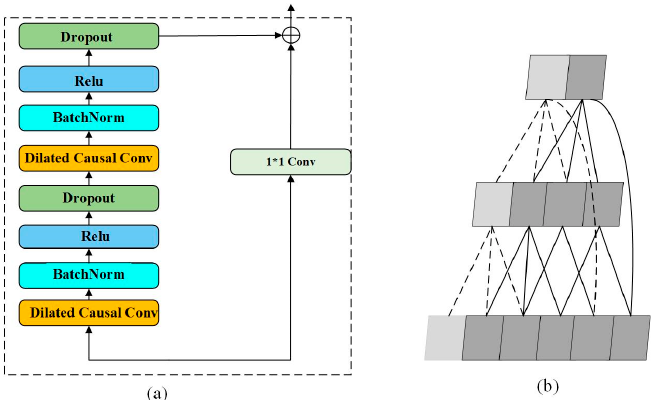
Figure 2. TCN residual module. ( a ) residual block containing two basic units. ( b ) example of residual connectivity in TCN.